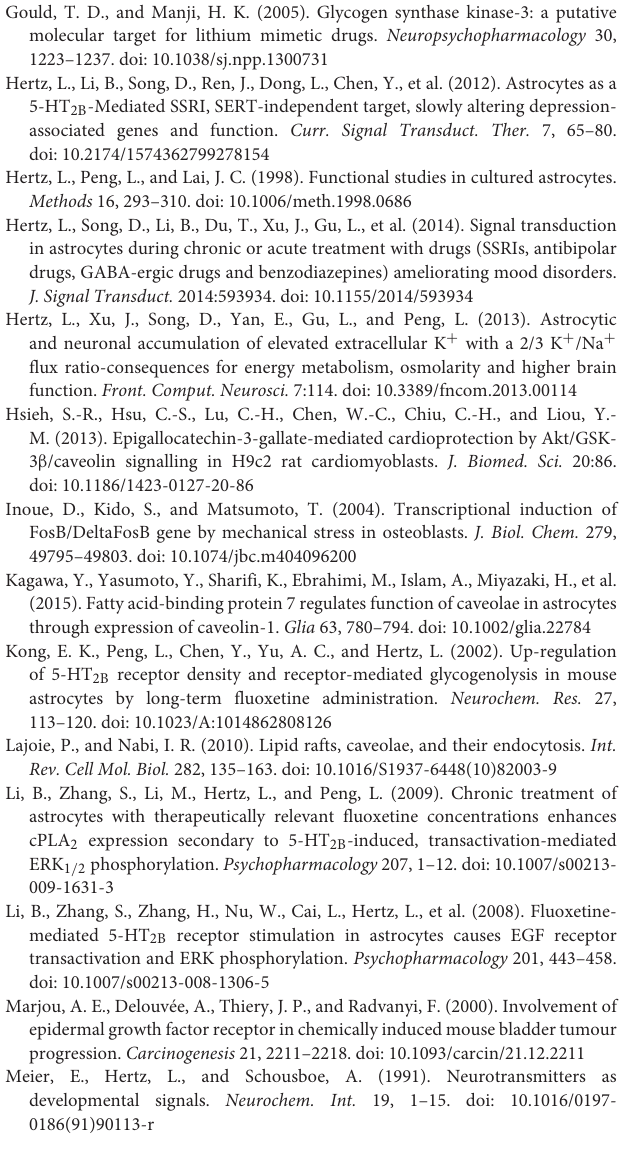
FIGURE S1 | Representative original images for the antibodies used in this study. (A) p-ERK, (B) ERK, (C) p-AKT, (D) AKT, (E) c-Fos and FosB and (F)